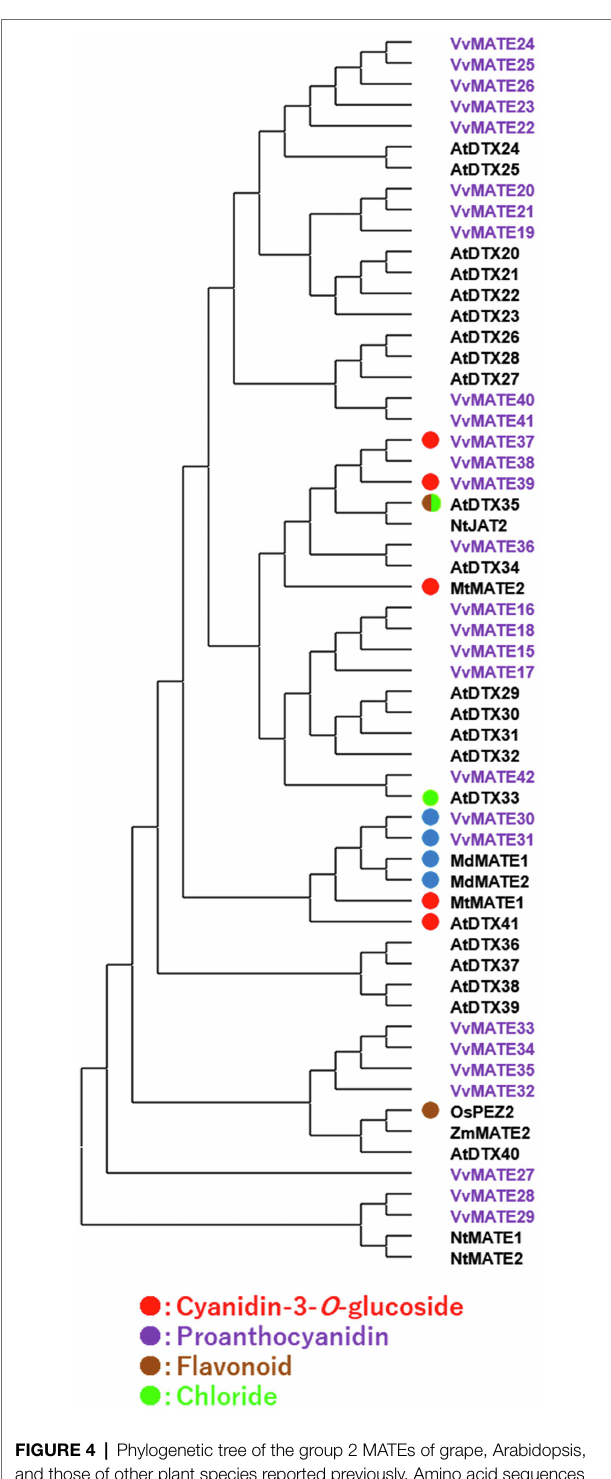
FIGURE 4 | Phylogenetic tree of the group 2 MATEs of grape, Arabidopsis, and those of other plant species reported previously. Amino acid sequences of the MATEs of grape and those of other plant species (Li et al., 2002; Takanashi et al., 2014) were aligned using the ClustalW program. The phylogenetic tree was created by MEGAX using the neighbor-joining model. The group2 of grape MATEs are indicated with purple. Substrates of the MATEs with circles have been reported previously (different colors show different substrate, Takanashi et al., 2014; Zhang et al.,